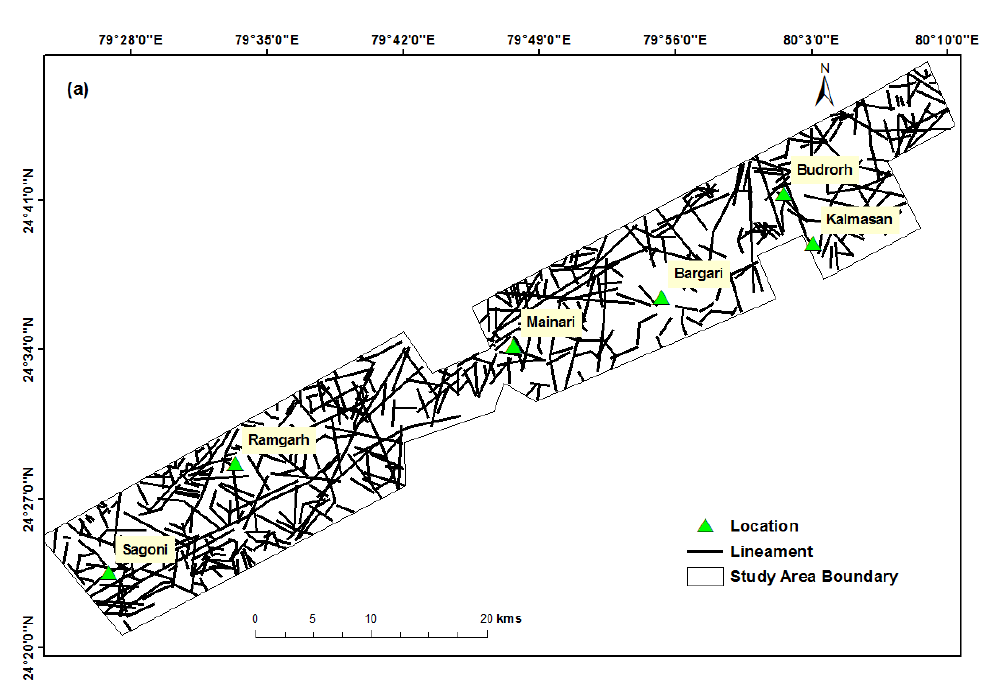
Figure 2. Lithological map of the study area with few large lineament and few discovered kimberlite/lamproite pipe( Source: GSI map,